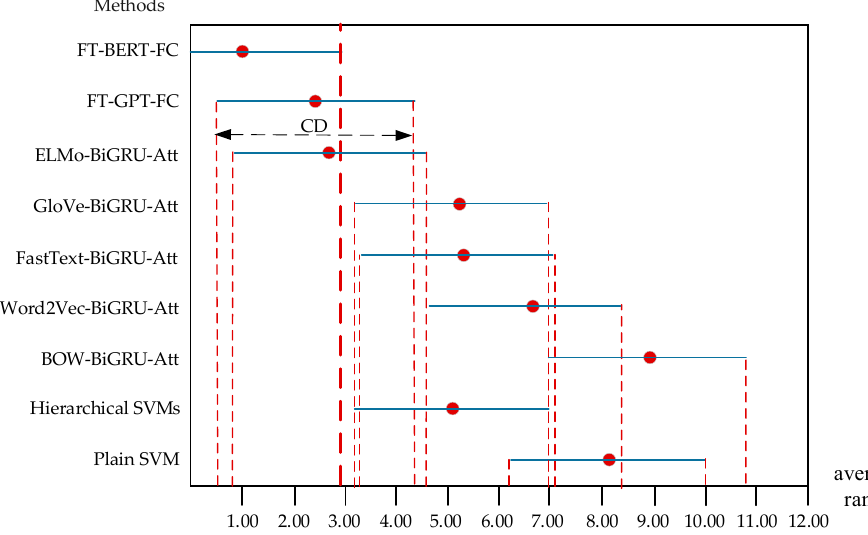
Figure 6. Comparison of all methods against each other with Nemenyi test.